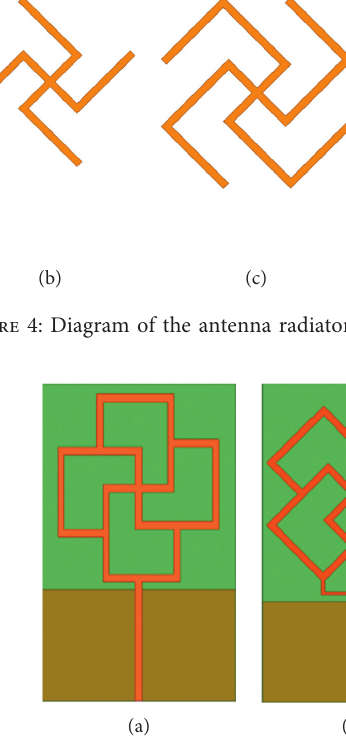
Figure 5: Model comparison. (a) Basic model. (b) Final